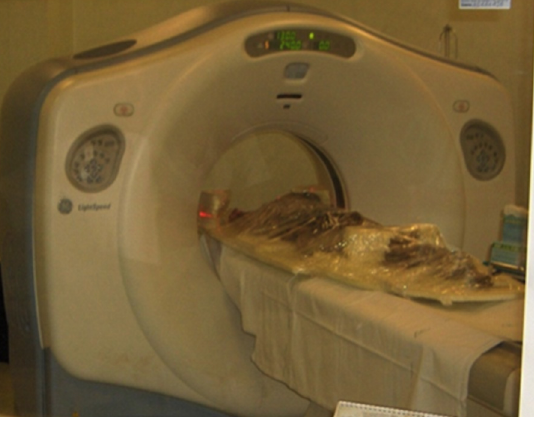
Fig 2. Mummies sited on rigid support and examined with CT